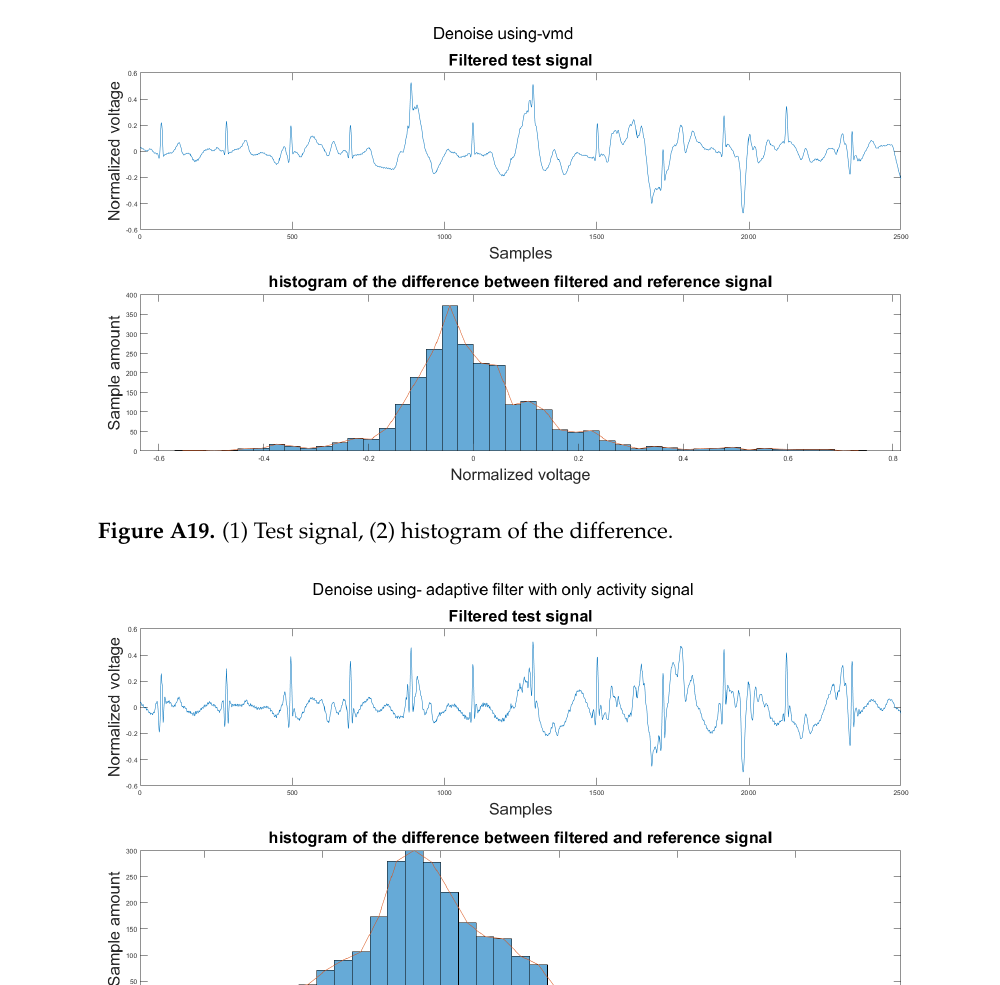
Figure A18. (1) Test signal, (2) histogram of the difference.